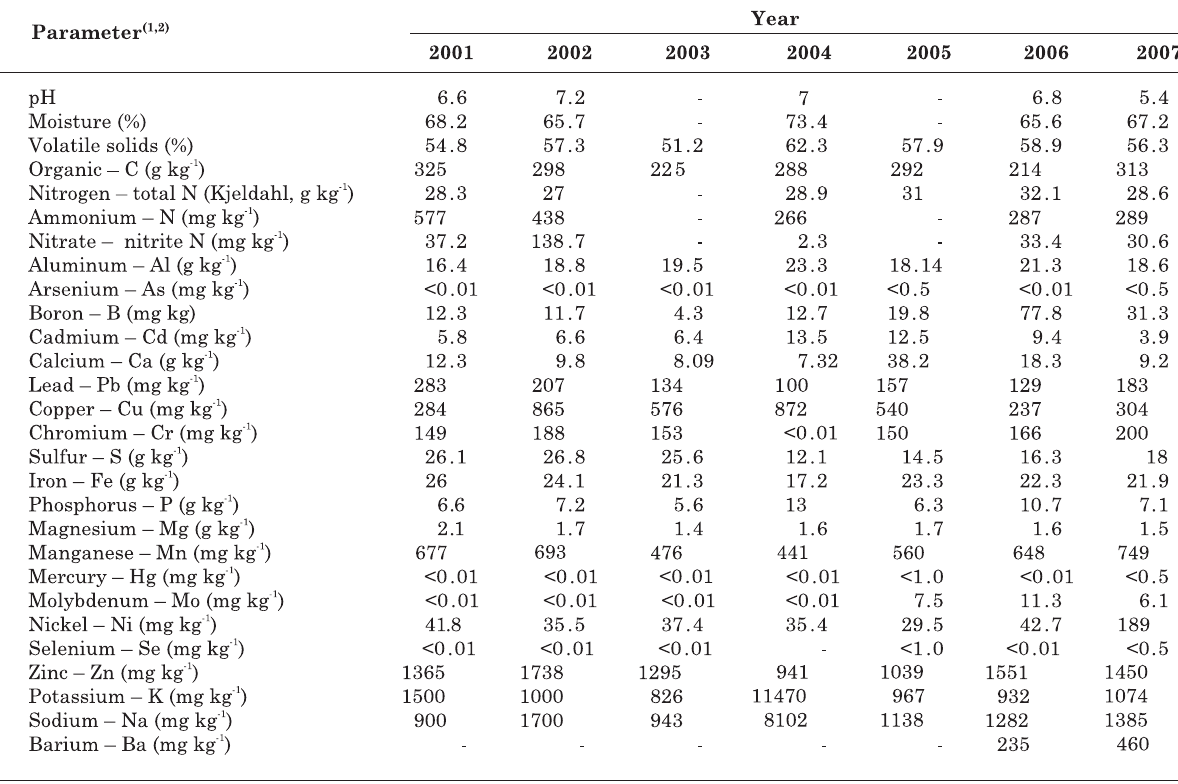
Table 1. Chemical composition of the sewage sludge applied in a Red Latosol cultivated for maize cultivation during the period of